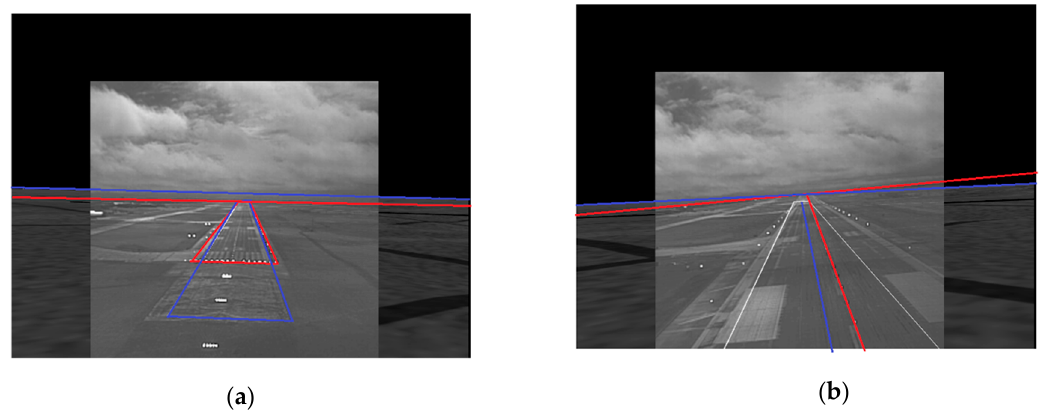
Figure 6. Examples EVS-SVS image fusion without prior registration. ( a ) EVS and SVS runways and horizons are not aligned; ( b ) EVS and SVS horizons and center lines are not aligned.